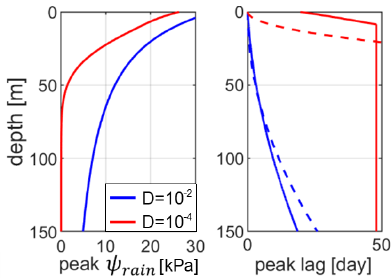
Figure A1. Maximum rainfall response as a function of depth and its time lag for the synthetic recharge (Fig. 2). The time lag caps at 48d, maximum duration between the end of the recharge (2d) and the length of the time vector (50d). Dashed lines represent theoret- ical characteristic response times t c = z 2 /D , in comparison to the times of maximum response computed from the model.